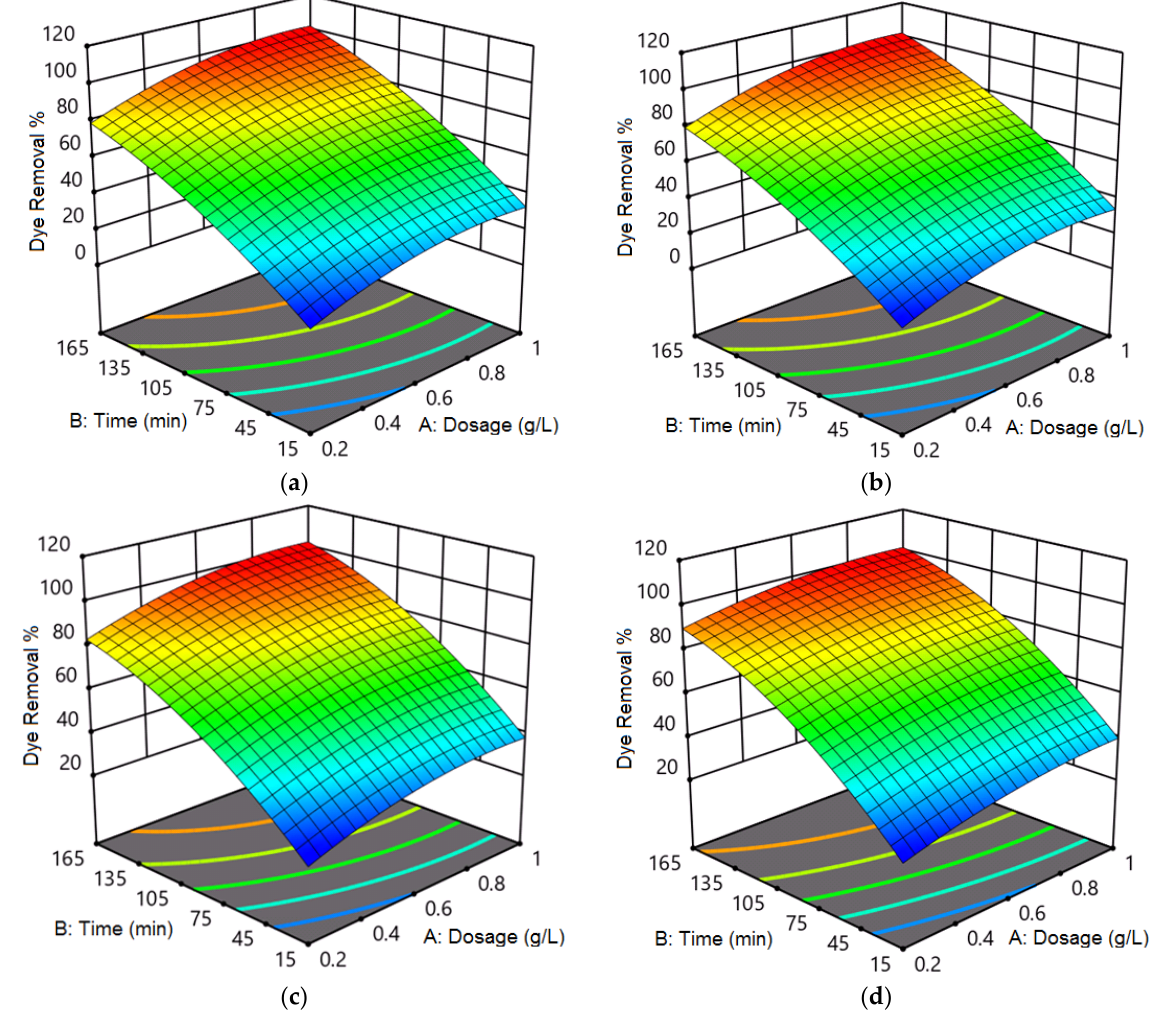
Figure 6. Interactive effect of photocatalyst dosage and contact time on photocatalytic removal of ( a ) RhB and ( b ) MB dyes using Zn 50 Mg 50 O, and ( c ) RhB and ( d ) MB dyes using G-Zn 50 Mg 50 O.